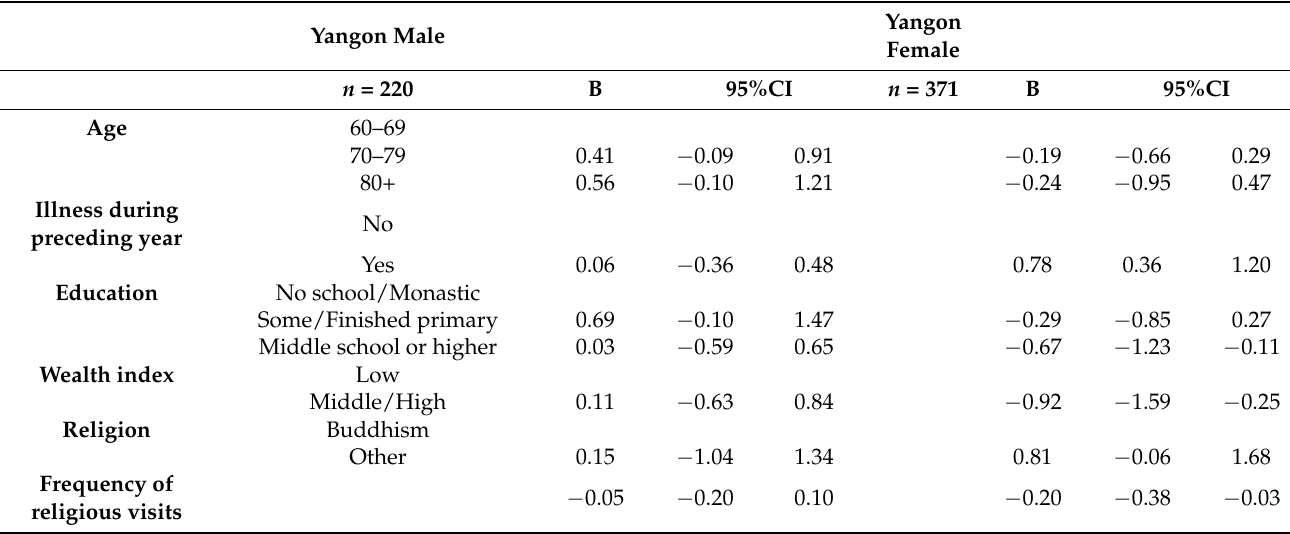
Table 3. Multivariate adjusted association between sociodemographic factors and Geriatric Depression Scale scores among the urban male & female older